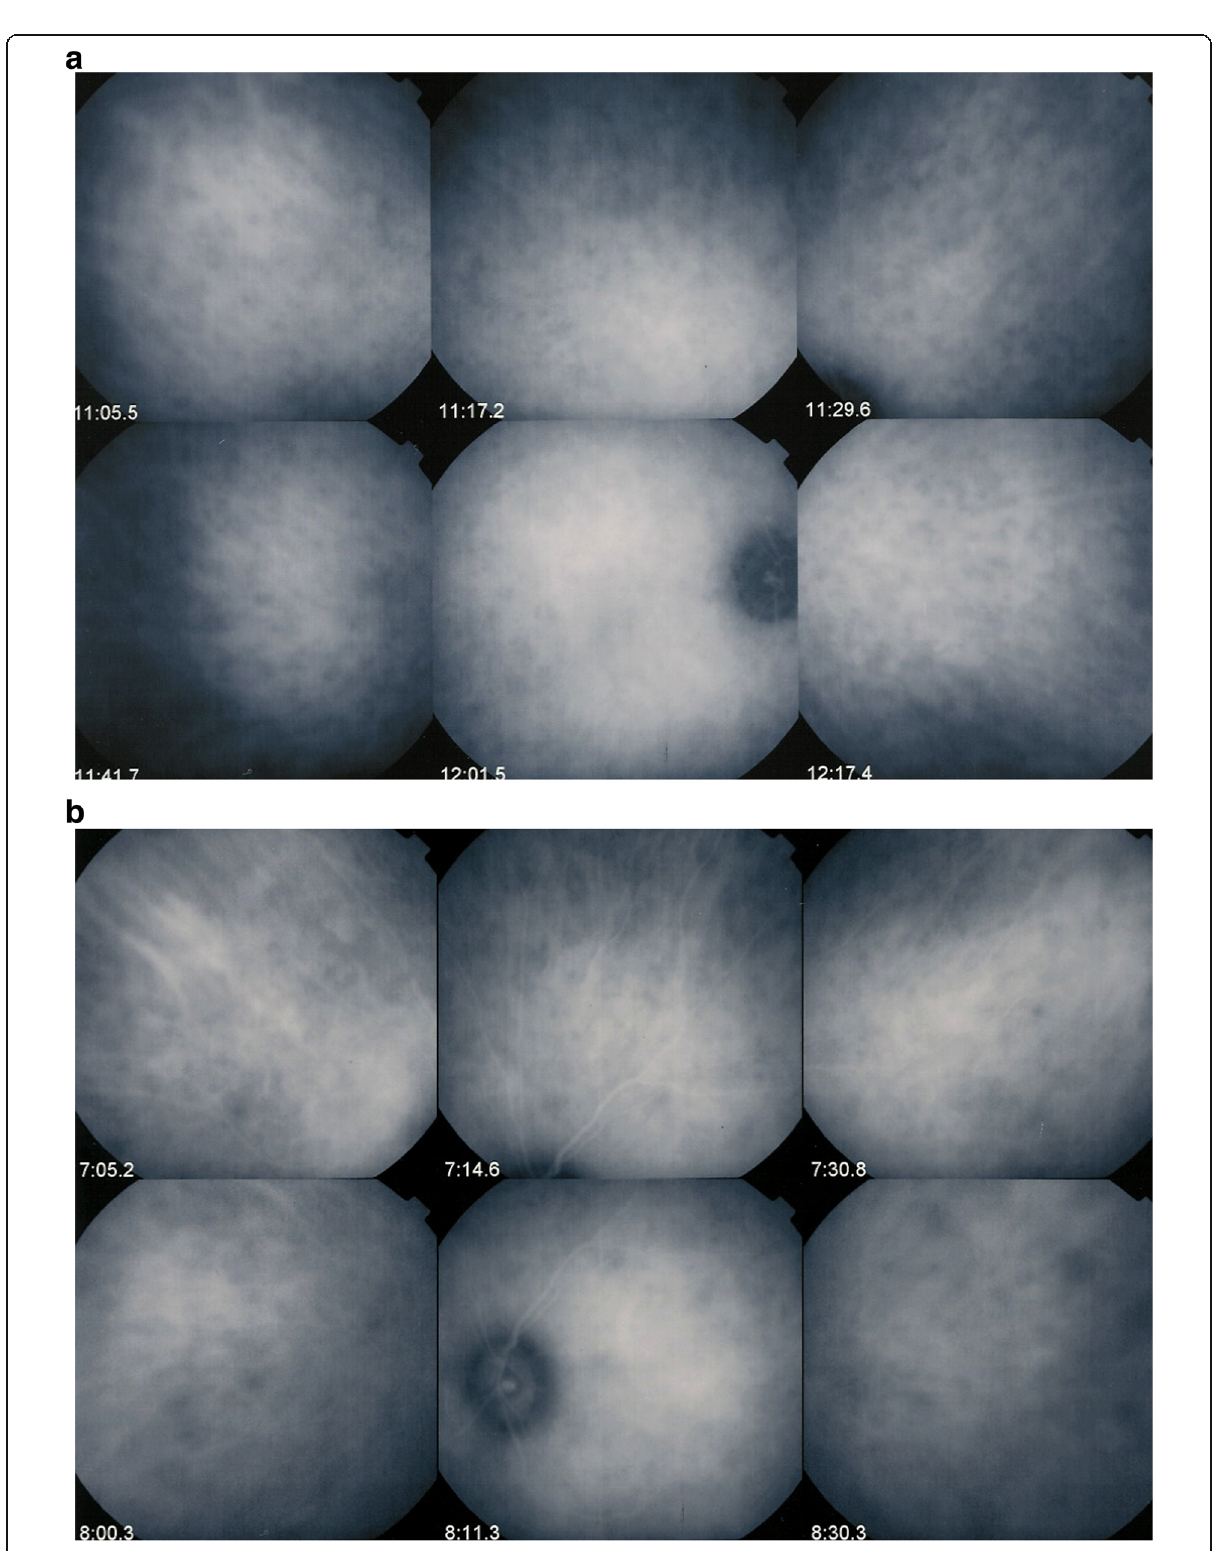
Fig. 3 a ICGA OD of VKH case at presentation. ICGA shows numerous evenly distributed HDDs and loss of identification of choroidal vessels, while fundus picture and FA are normal, identifying subclinical diffuse choroiditis. b ICGA OS of VKH case at presentation. ICGA shows numerous evenly distributed HDDs and loss of identification of choroidal vessels and ICGA disc hyperfluorescence indicating sever